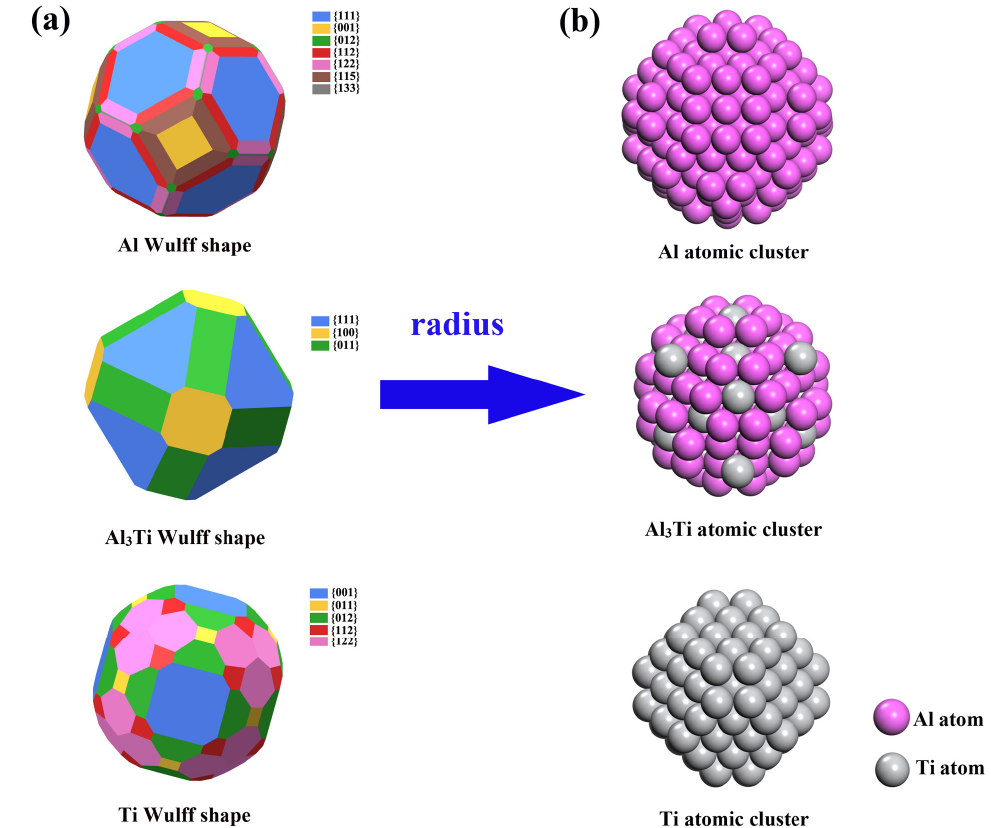
Figure 3. ( a ) The Wulff shape of Al, Al 3 Ti, and Ti (BCC). ( b ) The atomic cluster-determined radius of Al, Al 3 Ti, and Ti (BCC).